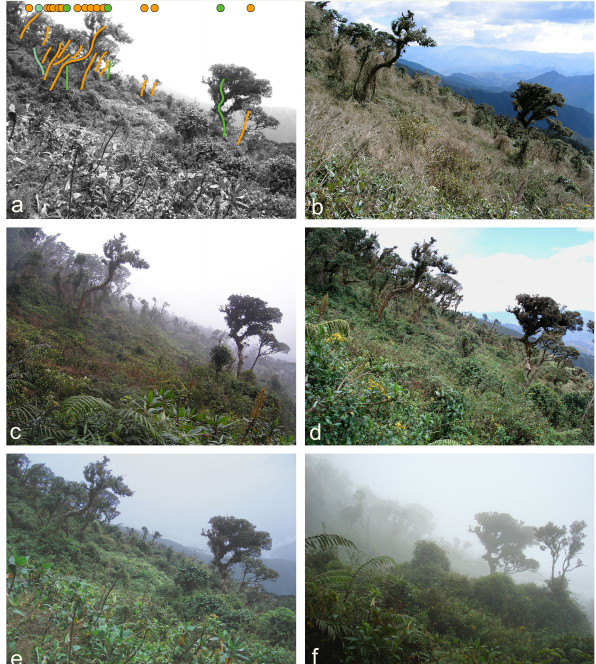
Fig. 4. Cohort mortality of Chusquea scandens (b) and subsequent plant sucession of herbaceous and shrubby pioneers (c–f) at about 3080ma.s.l. in Cajanuma. 14 inclined trees marked orange indicate the effect of debris creep, while 4 (green) are apparently unaffected by the slow mass movement process (a) . (b–f) taken in Octobre